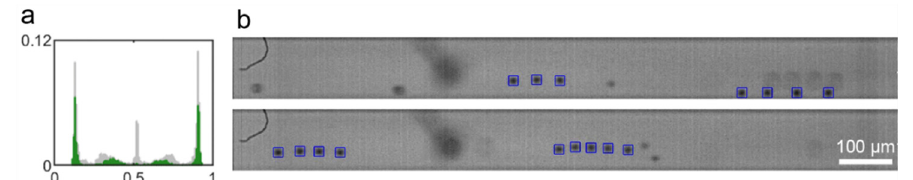
Figure 7. ( a ) Probability density functions of all the 8.44-µm particles in grey and solely the particles in trains in green. ( b ) Channel pictures of 8.44-µm particles, in the channel midplane for Re = 280 at a distance from the channel inlet z/H = 1000 and a particle volume fraction Φ = 0.05%.